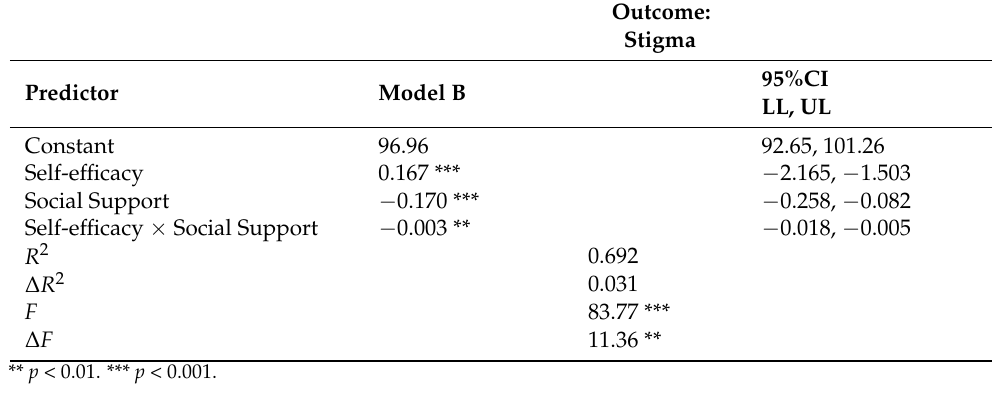
Table 3. Multiple Regression Analysis for the moderating role of Social Support within the relation- ship of Self-Efficacy and Stigma (N = 116).